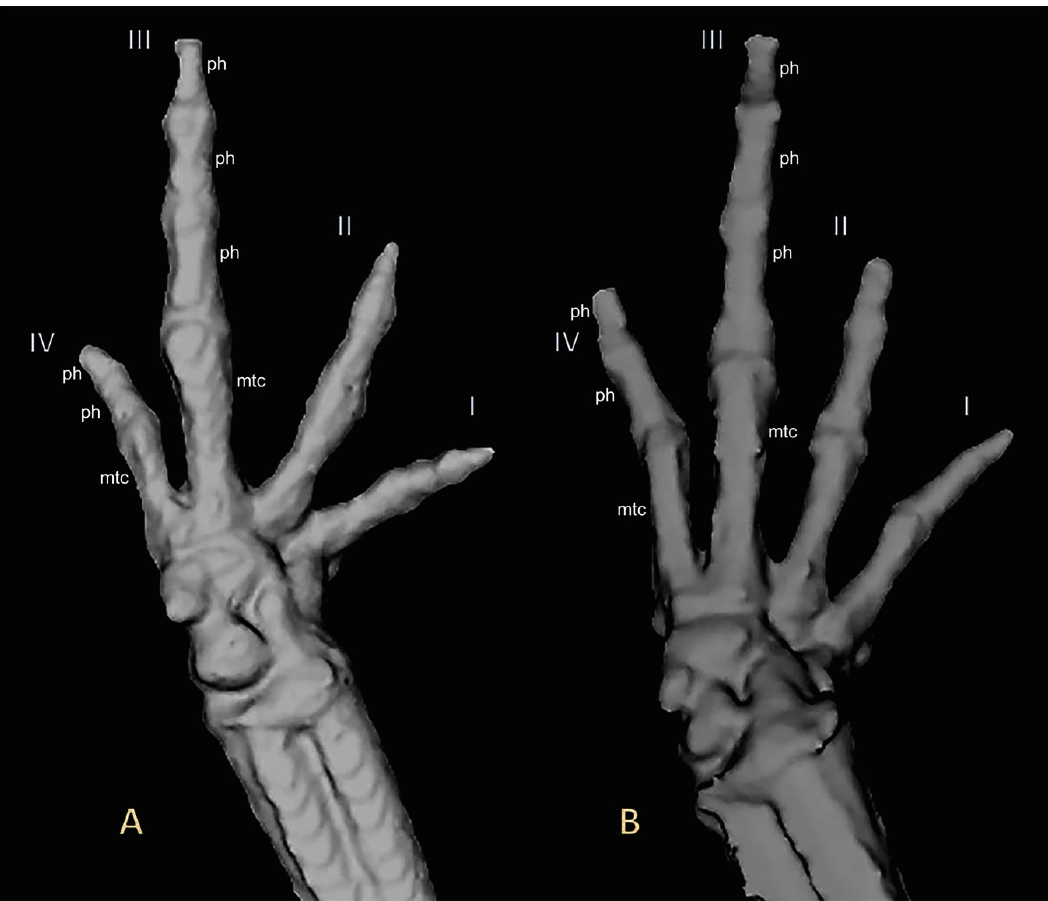
Figure 7. Three-dimensional reconstructions based on µCT data, from ( A ) adult right hand paratype UMMZ 246570 of Noblella losamigos sp. n. and ( B ) adult right hand Noblella myrmecoides from Loreto UMMZ 246571. Finger phalanges (ph) and metacarpalia (mtc) are noted for fingers III and IV.